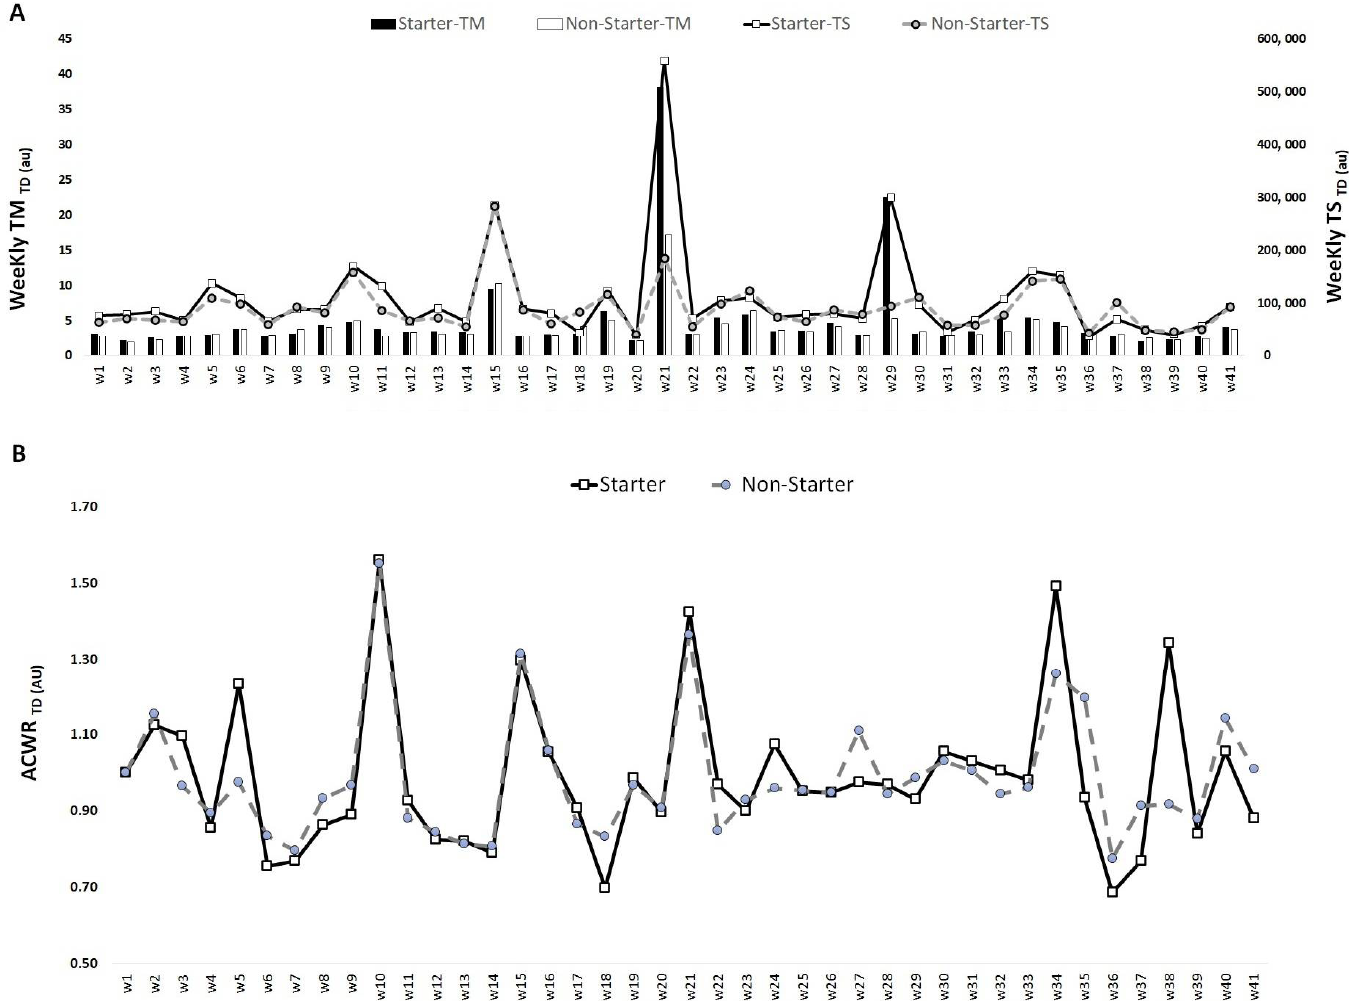
Figure 2. TM, TS ( A ) and ACWR ( B ) variations calculated through the total distance across 41 weeks for starters and non-starters.